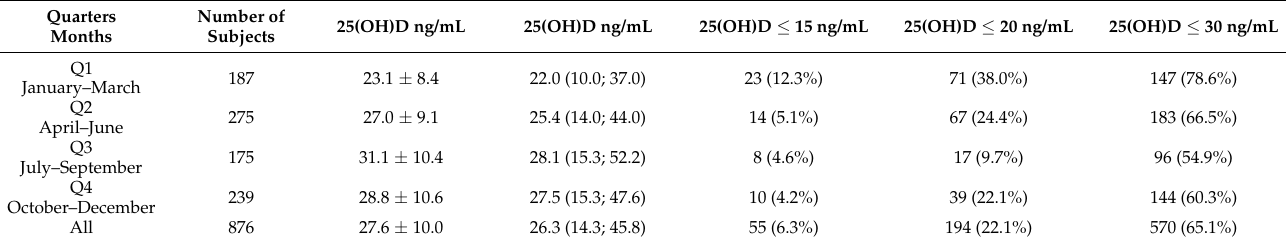
Table 5. Serum levels of 25(OH)D during the different quarters of the year.